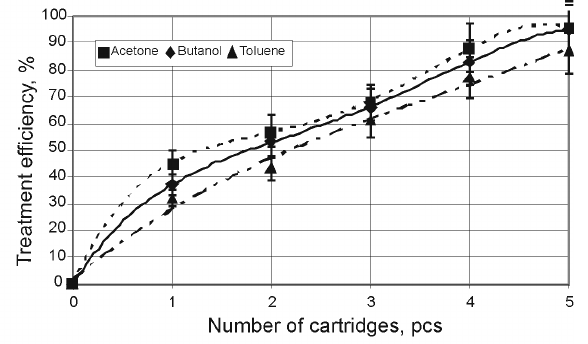
Fig. 4. Dependence of biofilter treatment efficiency on the number of cartridges when the velocity of supplied air flow is 0.1